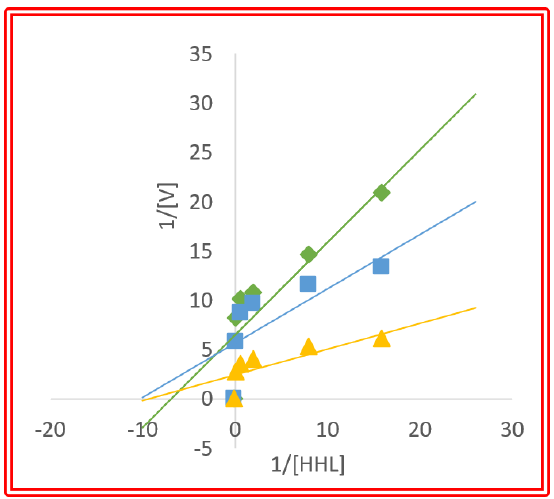
Figure 3. Michaelis_Menten kinetics on ACE-I inhibition by alcalase hydrolysate. Inhibitor concentrations of triangle 0, square 0.1 and diamond 0.25 mg/mL. trations of triangle 0, square 0.1 and diamond 0.25 Table 4. Kinetic parameters of hydrolysis of chickpea proteins by alcalase.